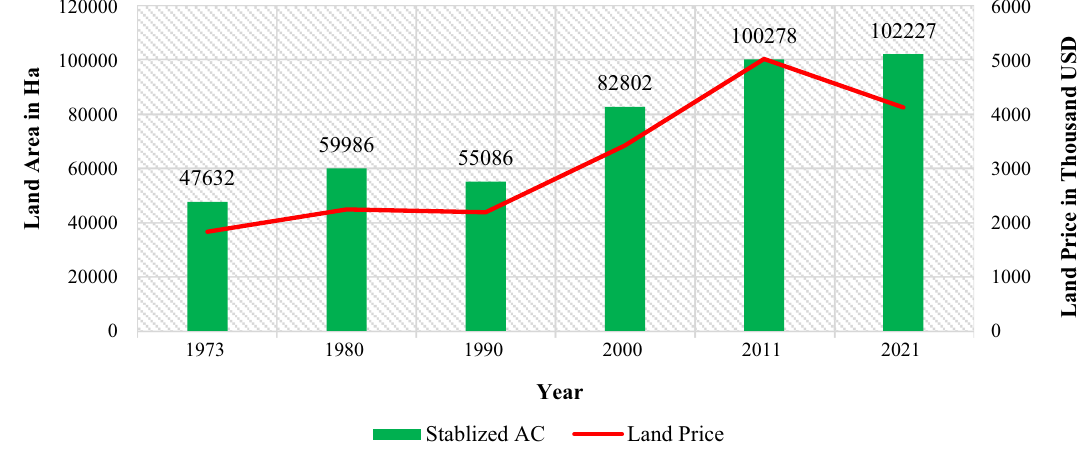
Fig. 10 Land price of the stable lands as part of economic valuation of NBS